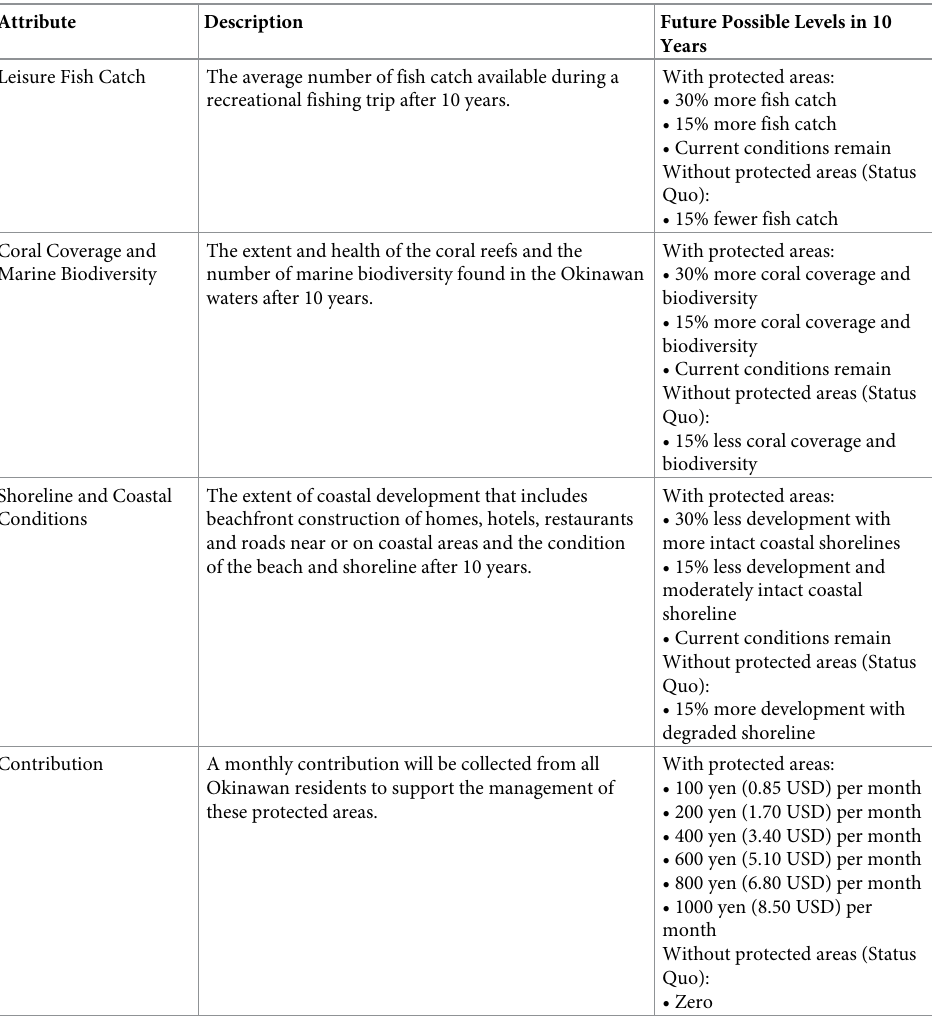
Table 1. Details and levels for